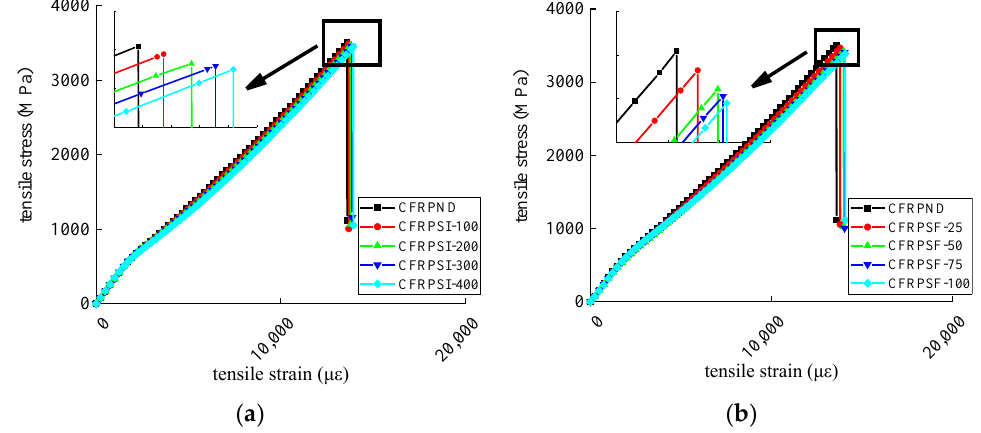
Figure 17. Stress – strain curve of CFRP sheet: ( a ) chlorine salt immersion environment and ( b ) salt- freeze coupled environment.